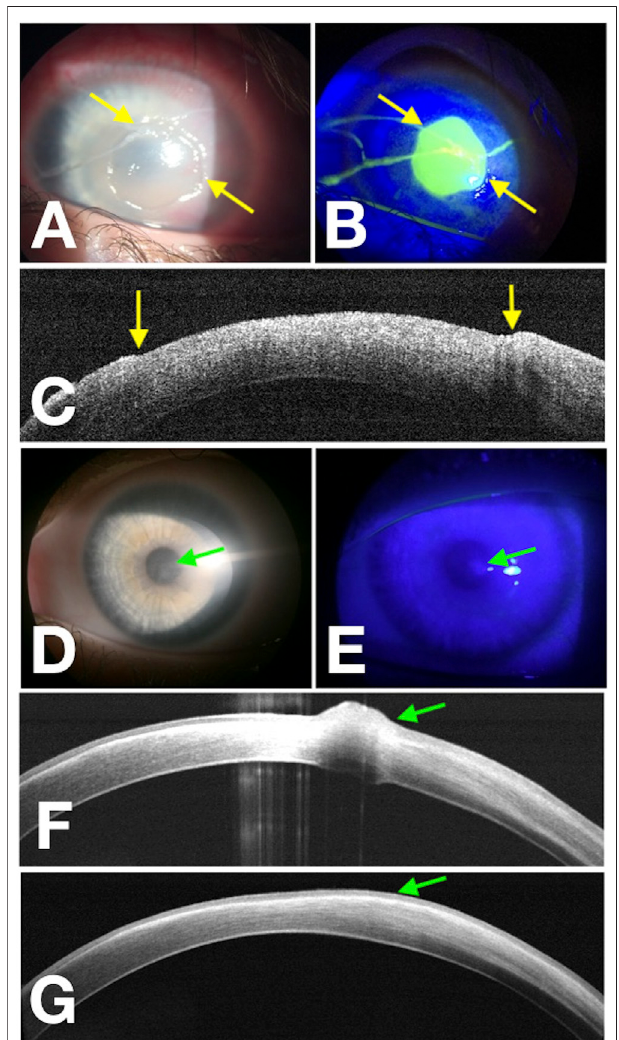
FIGURE 1 | Corneal wound healing of pediatric NK (rh-NGF Case 1) imaged with a multimodal approach. Yellow arrows point at the edges of the epithelial fronts in the photograph obtained at baseline with diffuse white light (A) , with fl uorescein staining (green) photograph obtained under cobalt- blue light illumination (B) , and points to the epithelial edges in the OCT scan over the thinnest areaat baseline (C) . (D – F) Images acquired at the end of the treatment at Week 8, and the green arrows show a residual paracentral corneal epithelial hyperplasia. About 1 month later, OCT scan (G) reveals complete regression of the corneal epithelial